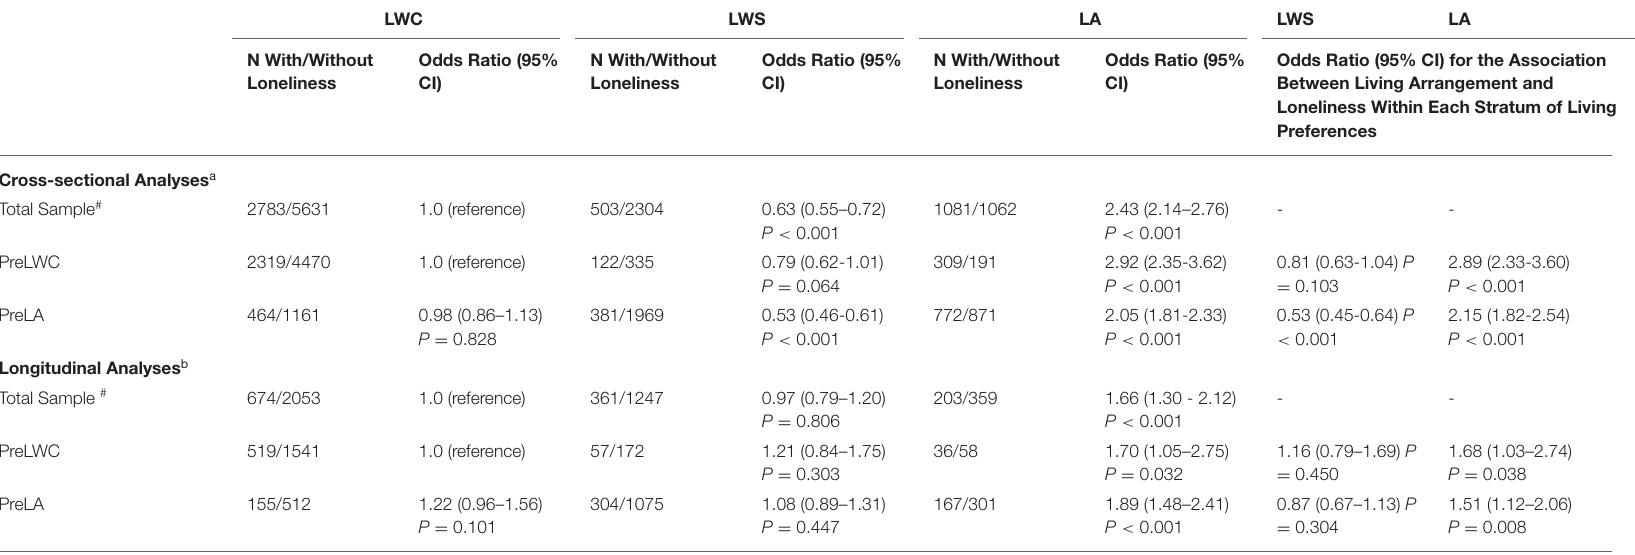
TABLE 3 | Modification of the effect of living arrangement on loneliness by living